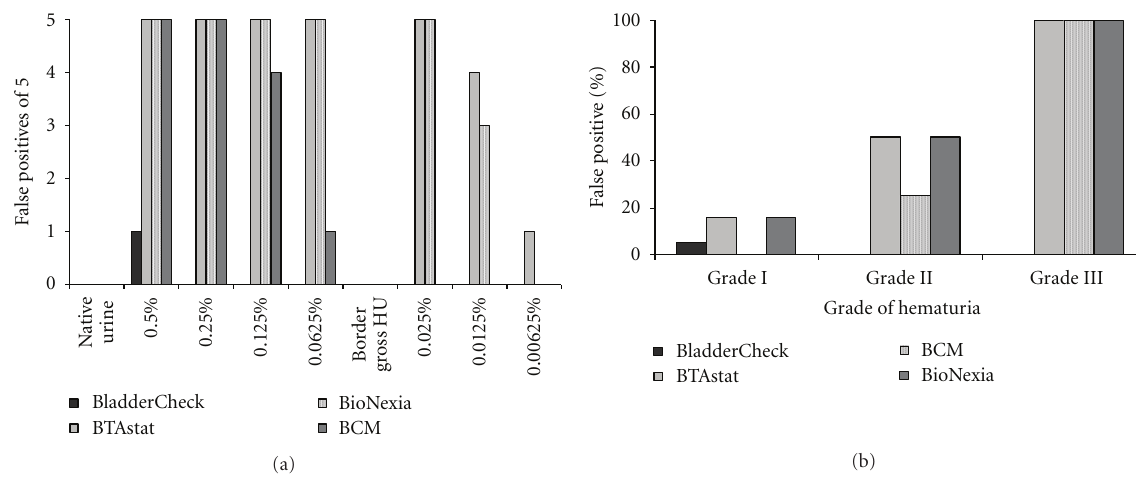
Figure 1: (a) False positive results of POCTs out of five patients per setting in di ff erent dilutions. HU: hematuria. (b) Rates of false positive test results and grades of hematuria in BC